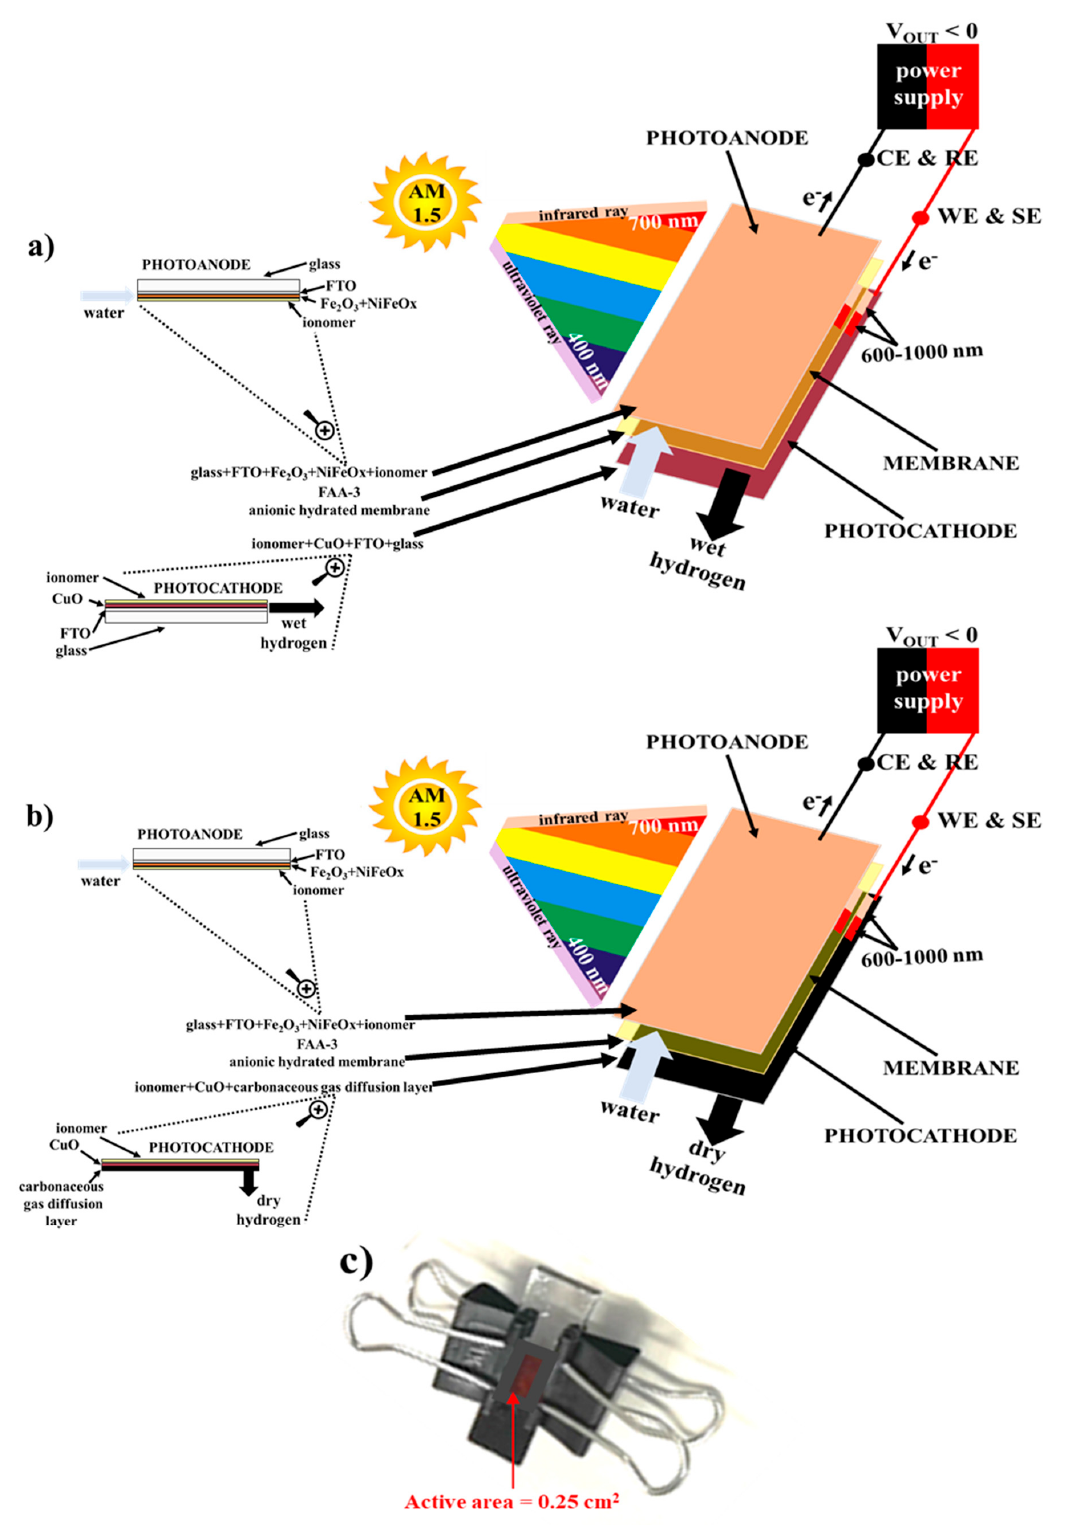
Figure 3. Schematic sketch of the photoelectrochemical cell (PEC) with conductive glass ( a ), carbonaceous gas diffusion layer ( b ) as cathode substrate; ( c ) photograph of PEC with carbonaceous gas diffusion backing layer as cathode substrate.